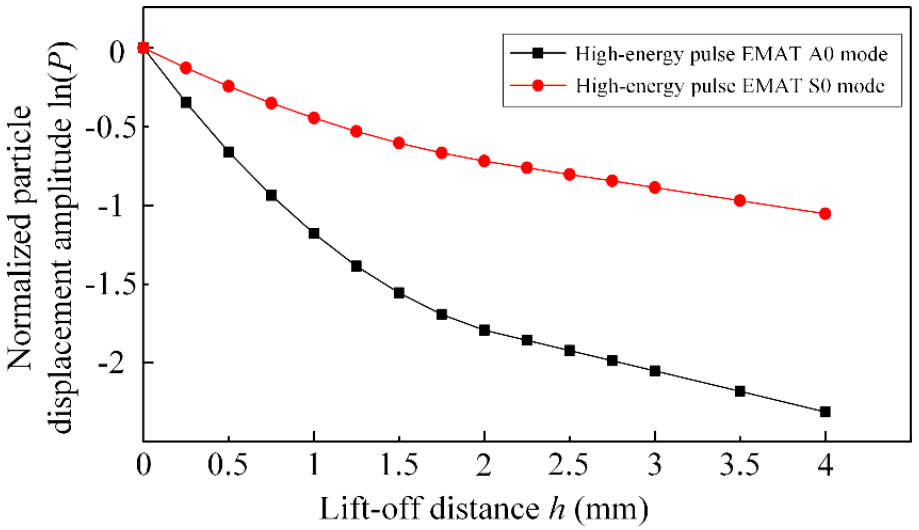
Figure 6. The relation between the logarithm of S0 mode and A0 mode amplitudes and lift-off distance in the simulation.